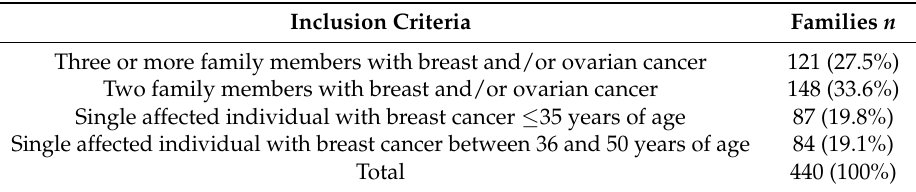
Table 1. Inclusion criteria for the families included in this